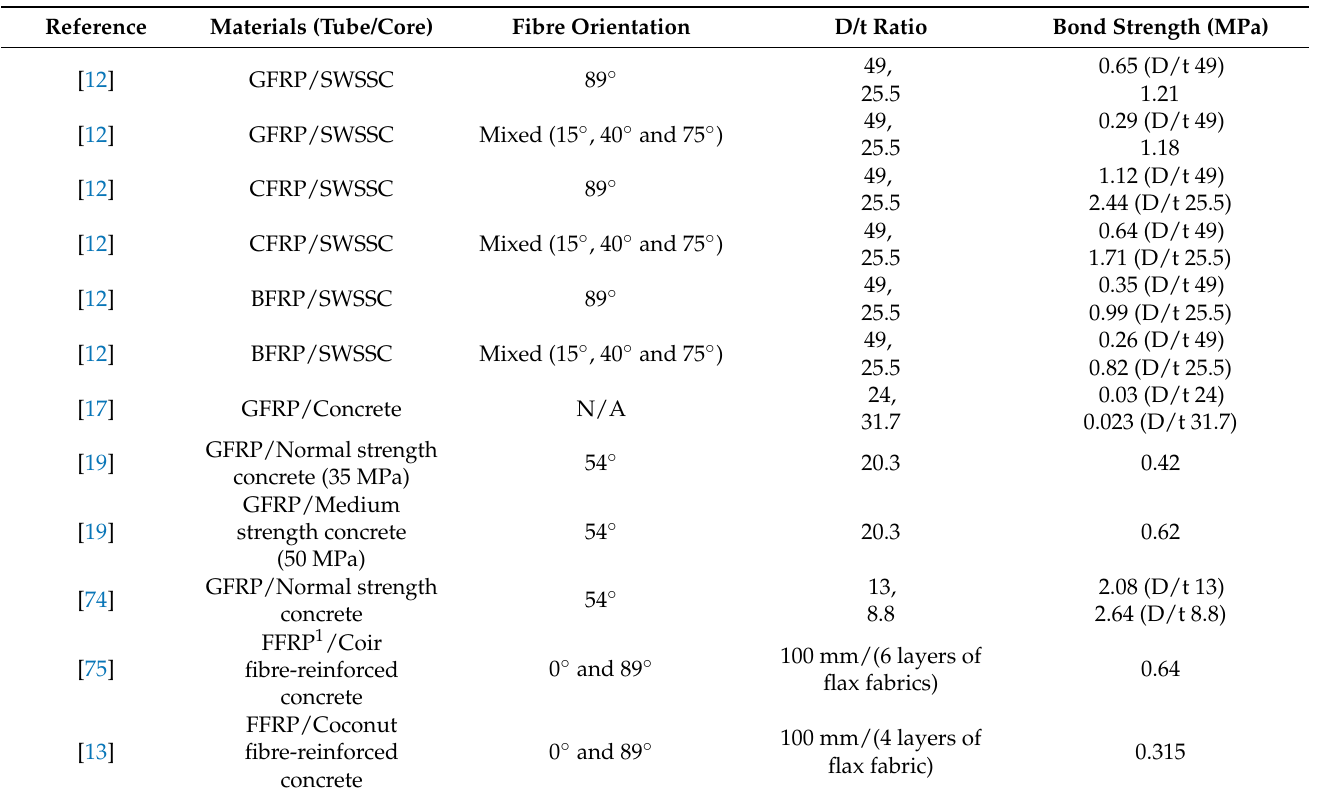
Table 4. Pushout test results of concrete filled FRP